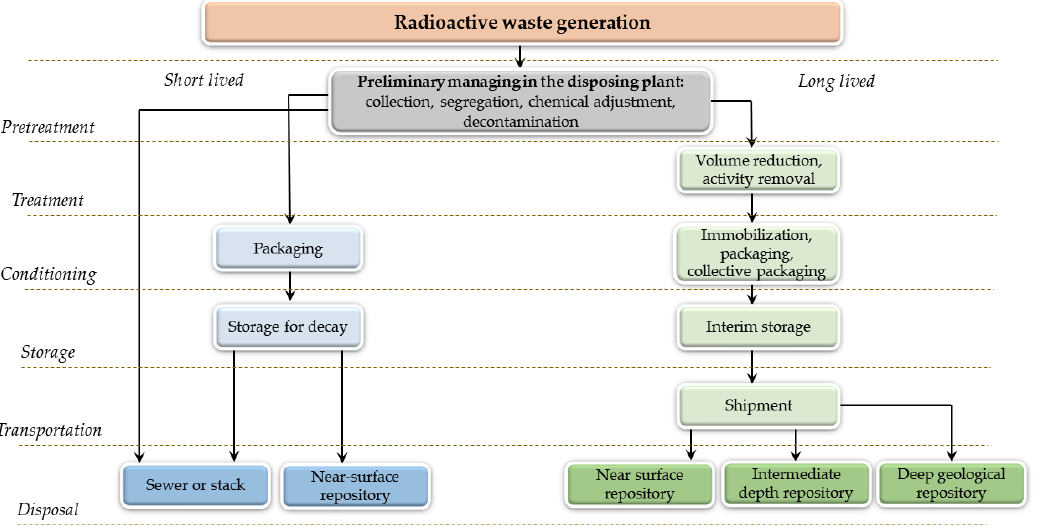
Figure 4. Main administrative and operational activities involved in radioactive waste